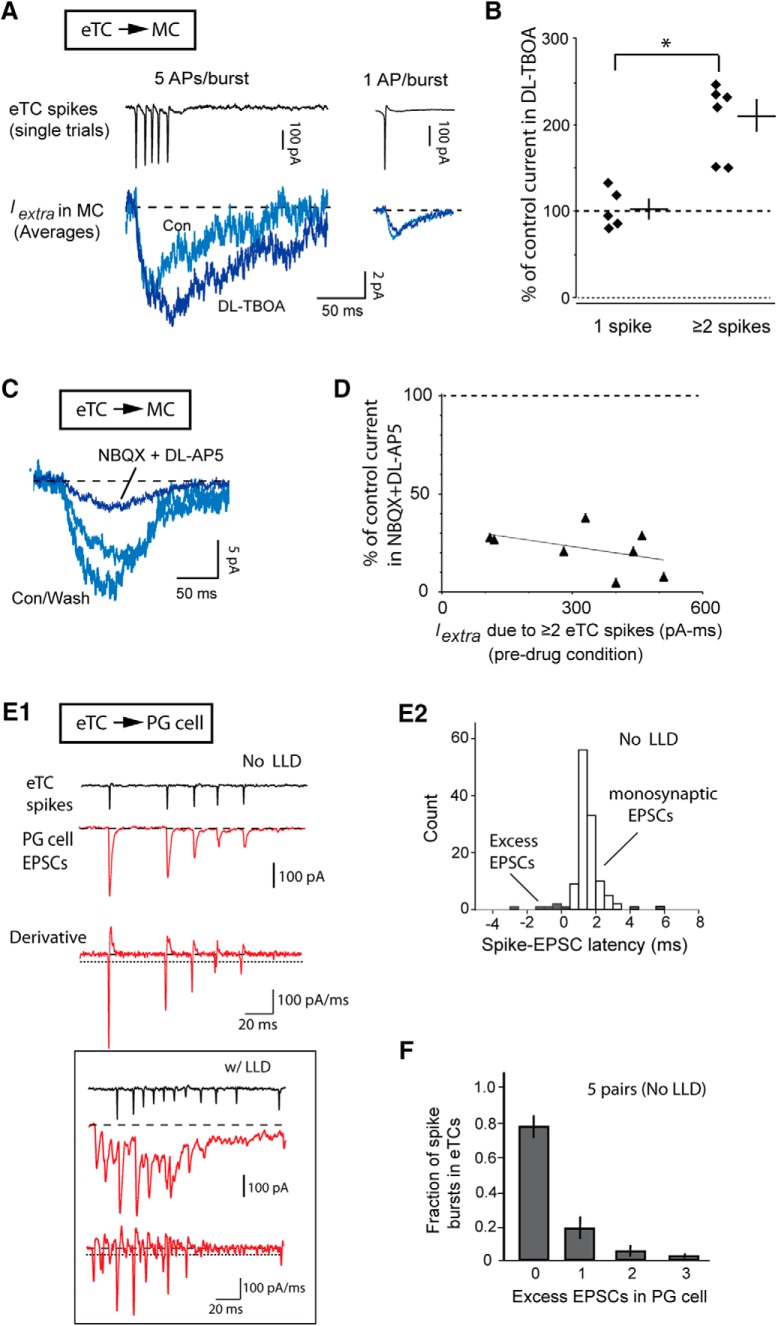
Tests of different mechanisms that could underlie the supralinear increase in extrasynaptic excitatory currents. A, Example eTC-MC pair recordings showing effects of the glial glutamate transporter blocker DL-TBOA (50 µM) on Iextra. Note that DL-TBOA enhanced Iextra when the eTC fired five spikes (left; averages of 12–15 bursts), but not when the eTC spiked only once (right; averages of 60). An increase that is selective for the multi-spike condition is inconsistent with glutamate transporter saturation being the cause of the supralinear increase in Iextra (see main text). B, Summary of the effect of DL-TBOA on Iextra separated by when the eTC spiked once (n = 5 pairs) versus two or more times (n = 6); *p = 0.0012 in unpaired t test comparing more than or equal to two- and one-spike datasets. Lines reflect mean ± SEM for the two conditions. C, Example recording of Iextra in MCs (averages of 12–15 trials) induced by eTC spike bursts (five spikes/burst) showing that the current was mostly blocked by the AMPA and NMDA receptor blockers, NBQX (10 µM) plus DL-AP5 (50 µM). This argued against the supralinear increase in Iextra being due to recruitment of a neurotransmitter other than glutamate. D, Effect of NQBX plus DL-AP5 as a function of the magnitude of Iextra elicited by more than or equal to two eTC spikes. Superimposed fitted line indicates lack of correlation (p = 0.25), providing further evidence against the largest Iextra signals being due to a non-glutamate neurotransmitter. Each of the eight data points reflects one eTC-MC pair recording. E, Test for recurrent excitation and asynchronous glutamate release. E1, Example analysis of a single burst event in an eTC-PG cell pair in the no-LLD condition. Note that each eTC spike had a single time-locked EPSC reflecting monosynaptic transmission, also evident in the derivative trace at bottom (horizontal dashed line = threshold). The absence of excess events argued against recurrent excitation or asynchronous glutamate release being the cause of the supralinear increase in Iextra. Box demarcates a burst event in the same recording in which there was a cooccurring LLD; in this example we counted 12 excess EPSCs in the PG cell. E2, Histogram reflecting latencies between eTC spikes and PG cell EPSCs in the no LLD-condition for the experiment in E1. Latencies of 0.5–3.5 ms (open bars) were considered to reflect monosynaptic transmission from the test eTC onto the PG cell. F, Distribution of the number of excess PG cell EPSCs per burst across five eTC-PG cell pair recordings under the no LLD-condition. Note that the large majority of burst events had no excess PG cell EPSCs.